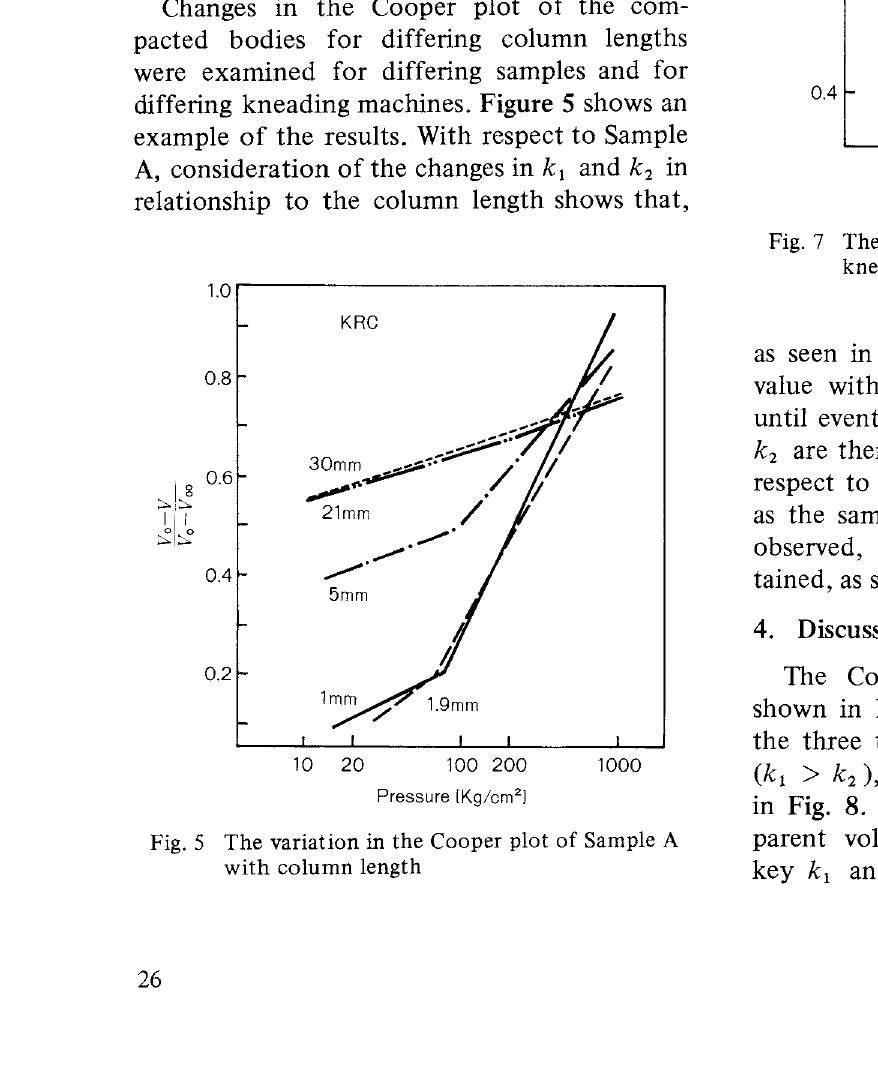
Fig. 7 The Cooper plot of Sample U-1 0 under repeat